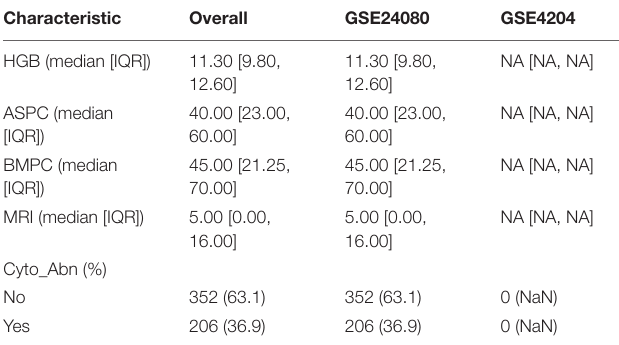
Frontiers in Genetics |